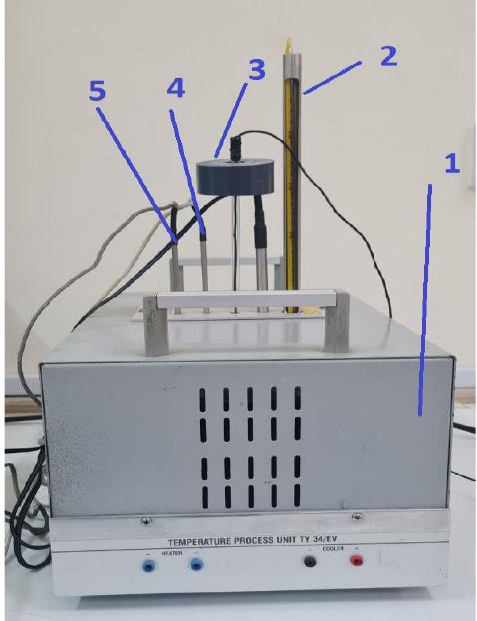
Figure 8. Heater system installation. (1 — the heater system, 2 — thermometer, 3 — acoustic temperature sensor, 4 — Pt100, 5 — NTC thermistor).